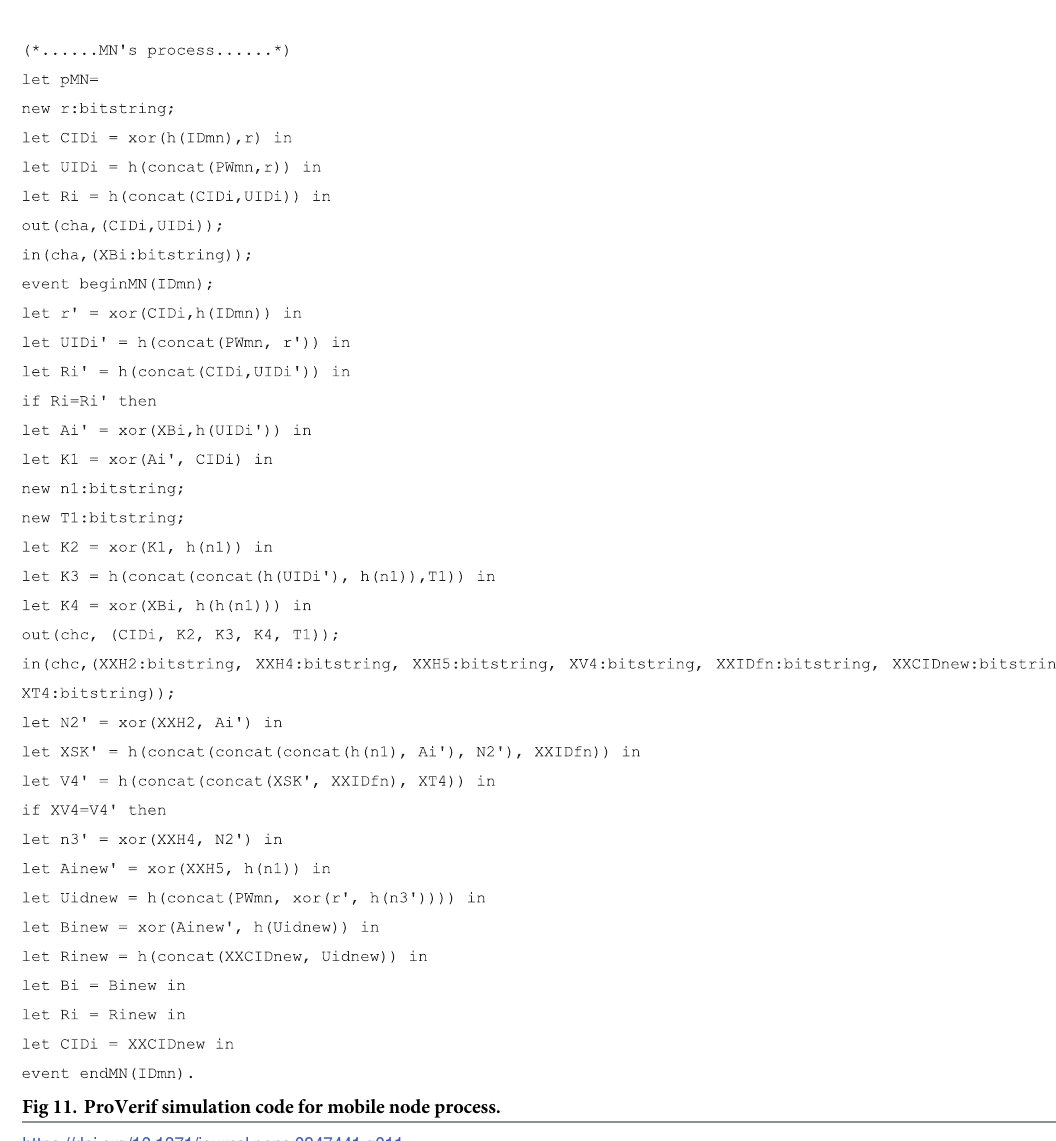
Fig 11. ProVerif simulation code for mobile node